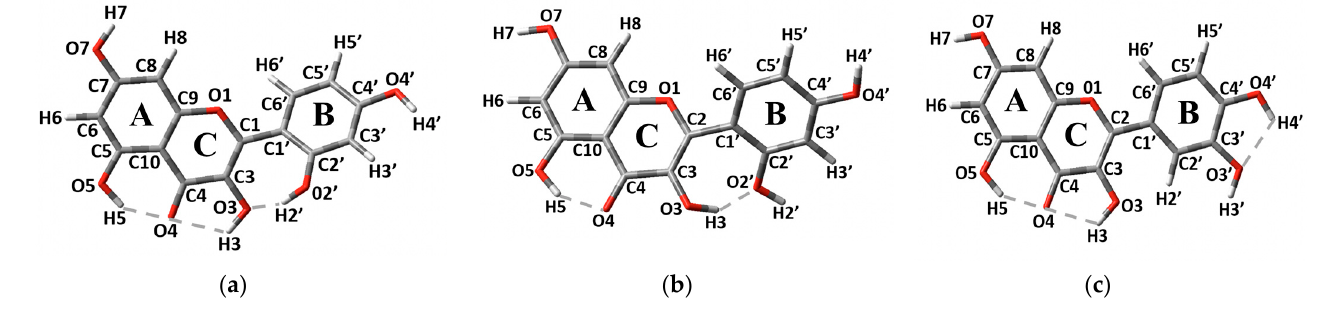
Figure 1. Two molecular configurations of M reported in crystals of MH [4] MCA ( a ), MCB ( b ) and the structure of the Q molecule ( c ). A, B and C are labels typically used for flavonoid molecule’s rings.